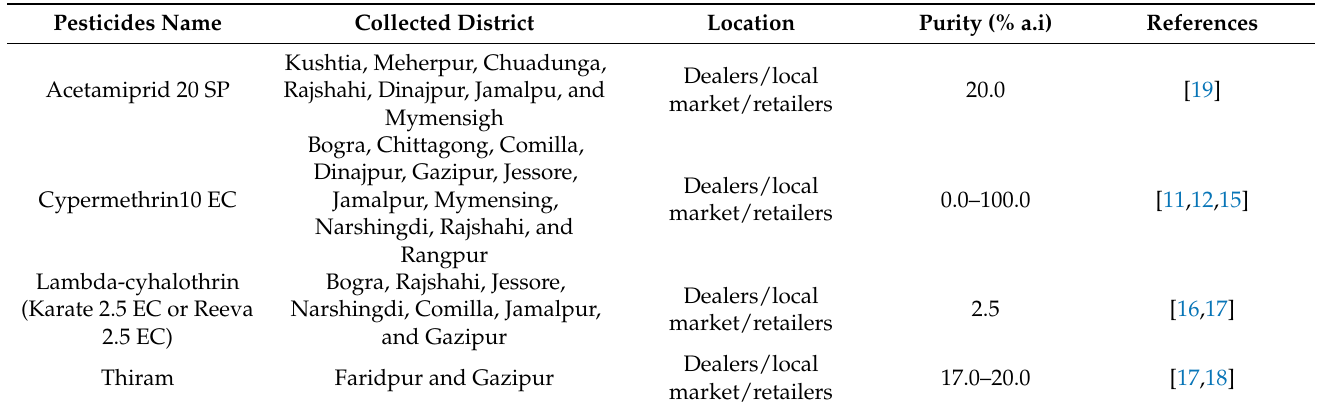
Table 2. Percentage of active ingredient present in some marketed brands of pesticides.